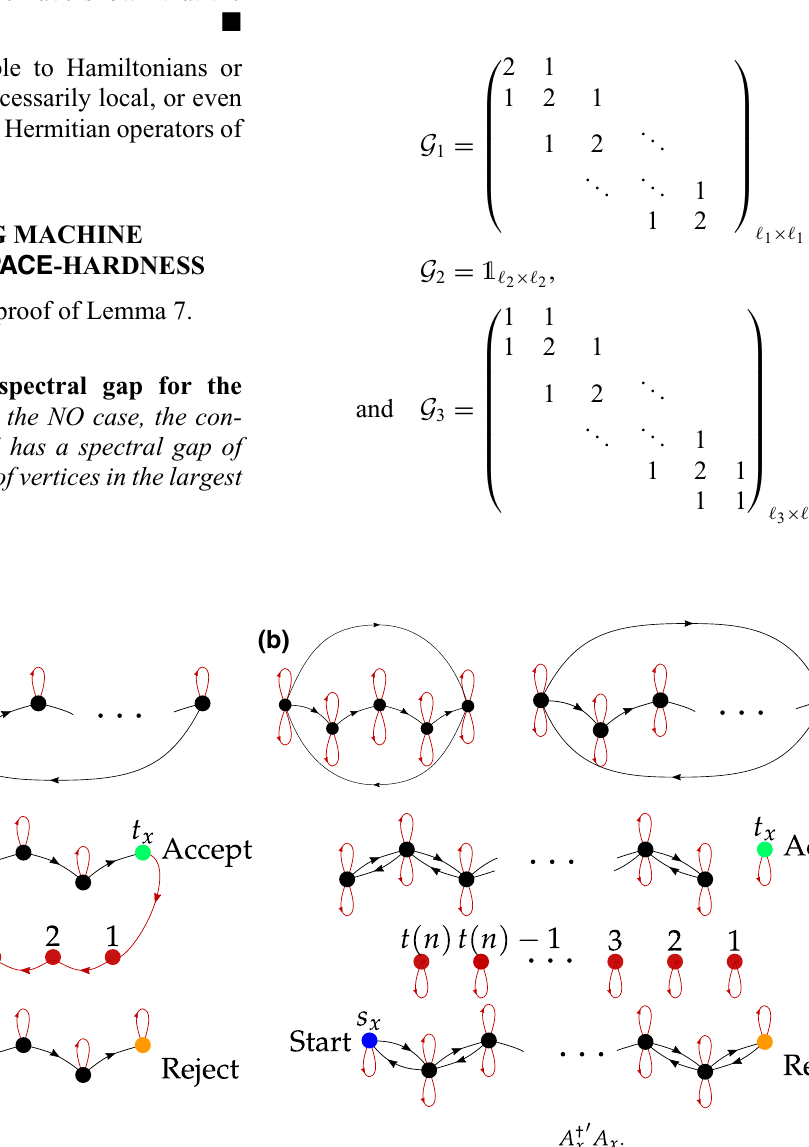
FIG. 4. (a) Graph G (cid:14) with adjacency matrix A (cid:14) , adapted from Fig. 2(d). (b) Graph with (weighted, directed) adjacency matrix A † x x x Vertices with two self-loops can be thought of as a single self-loop with weight